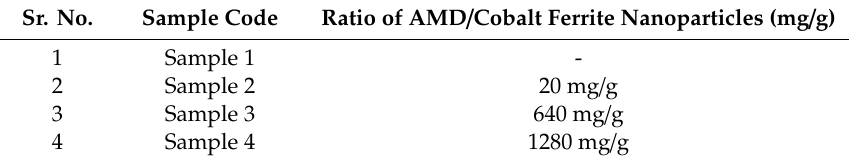
Table 1. Codes of di ff erent samples prepared with di ff erent ratios of aminodextran (AMD). Sr.